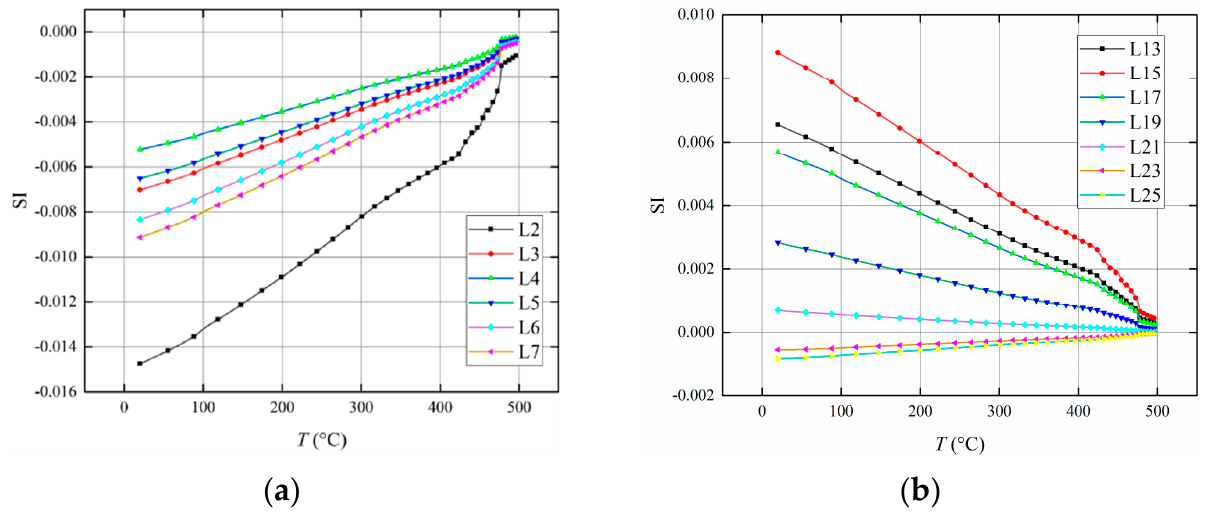
Figure 9. Law of the sensitivity coefficient with temperature. ( a ) Circumferent ribs; ( b ) radial ribs.